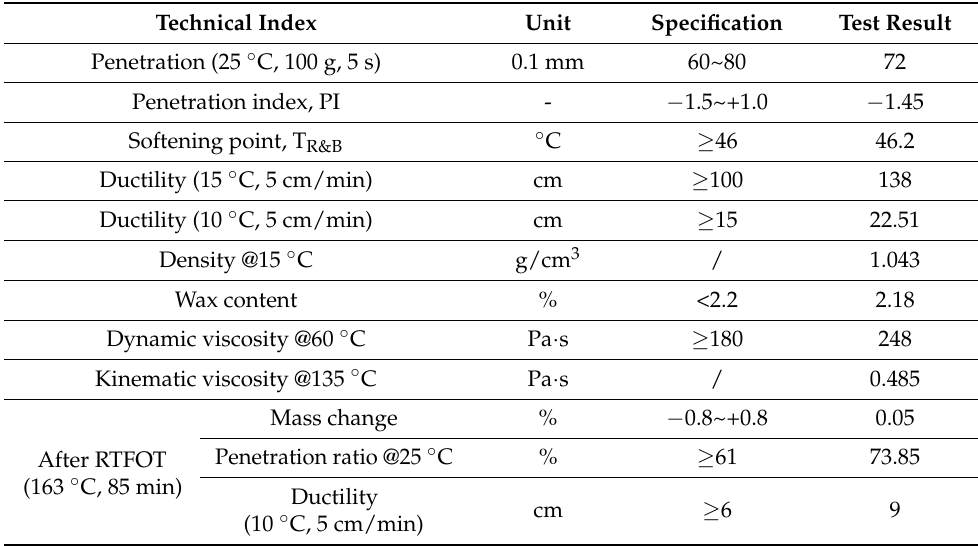
Table 1. Technical indices of the A-70# petroleum asphalt